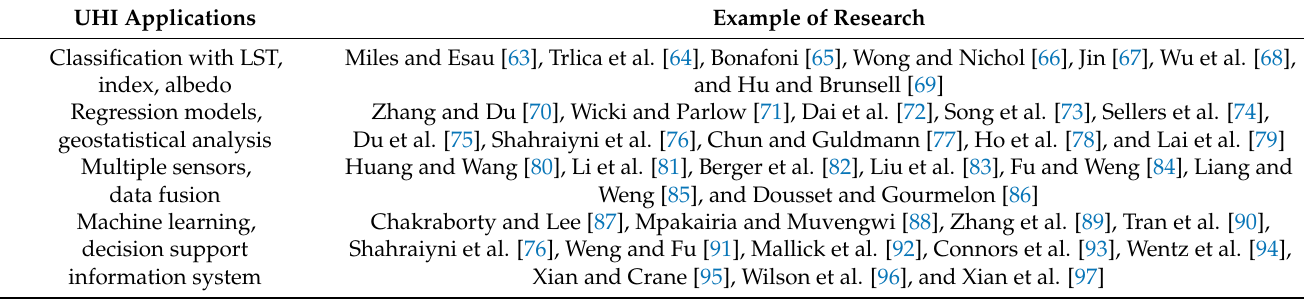
Table 2. Examples of research publications investigating UHI and UHIRIP using remotely sensed data. UHI Applications